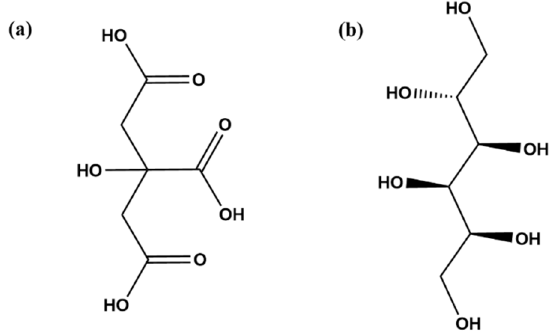
Figure 1. Chemical structure of ( a ) citric acid and ( b ) sorbitol.